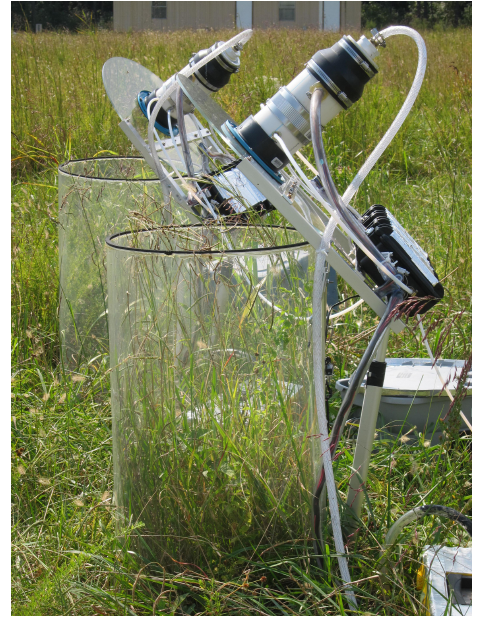
Figure 1. The photo above shows a pair of flux chambers at the field site in the Duke